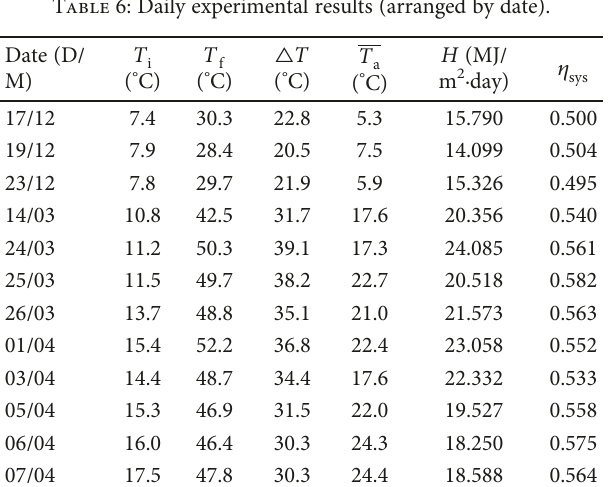
Table 6: Daily experimental results (arranged by